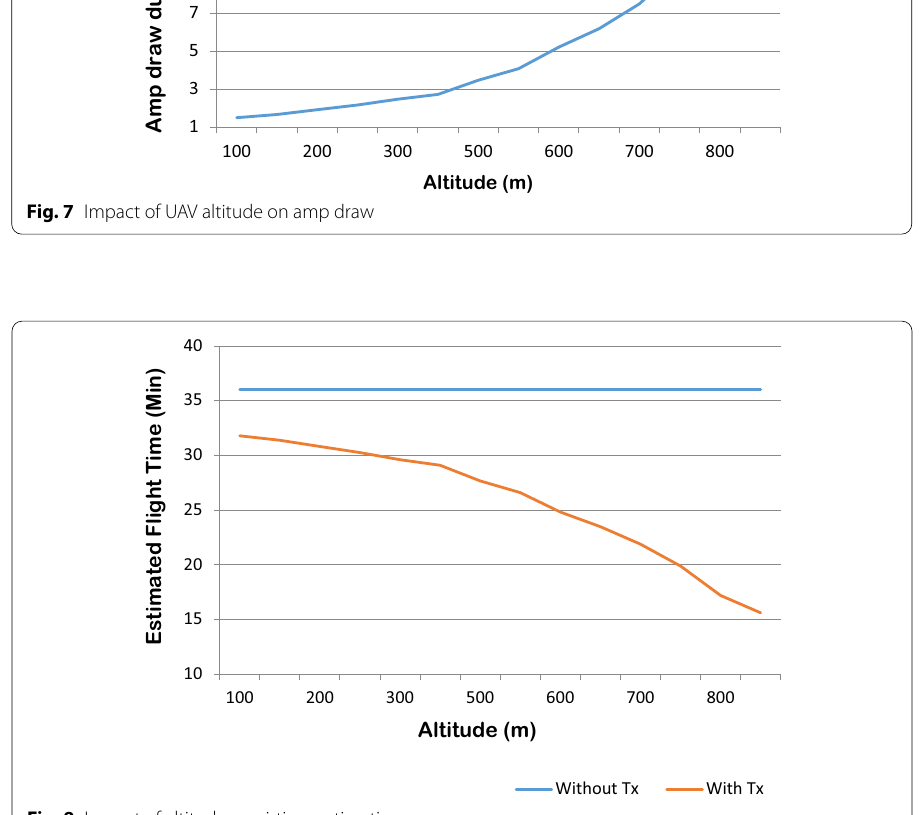
Fig. 8 Impact of altitude on airtime